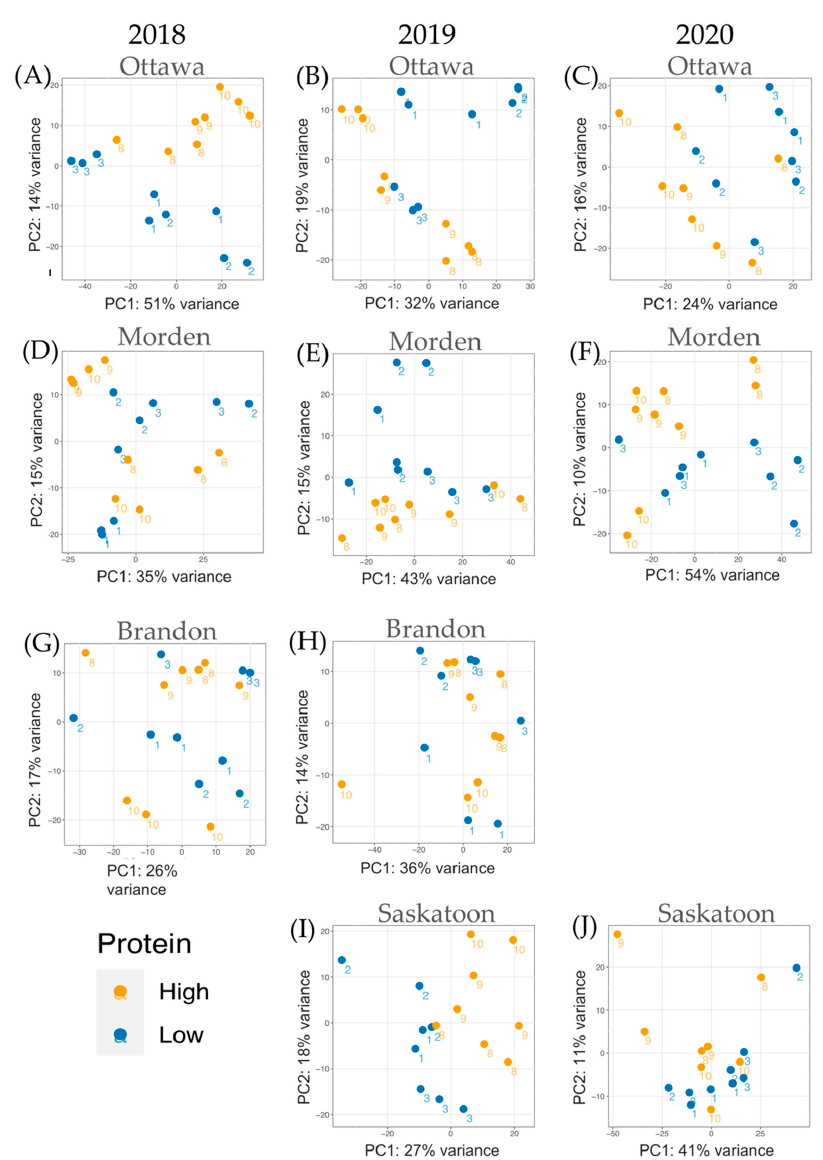
Figure 2. PC analysis of normalized RNA-seq expression data for samples included in each individual DE analysis across the four locations and three years. Each TP year-location dataset is represented: ( A ) Ottawa 2018, ( B ) Ottawa 2019, ( C ) Ottawa 2020, ( D ) Morden 2018, ( E ) Morden 2019, ( F ) Morden 2020, ( G ) Brandon 2018, ( H ) Brandon 2019, ( I ) Saskatoon 2019, ( J ) Saskatoon 2020. Orange datapoints represent high TP samples, blue datapoints represent low TP samples. No data collected from Saskatoon 2018 and Brandon 2020. The line number (1, 2, 3, 8, 9, 10) for each corresponding datapoint is indicated.